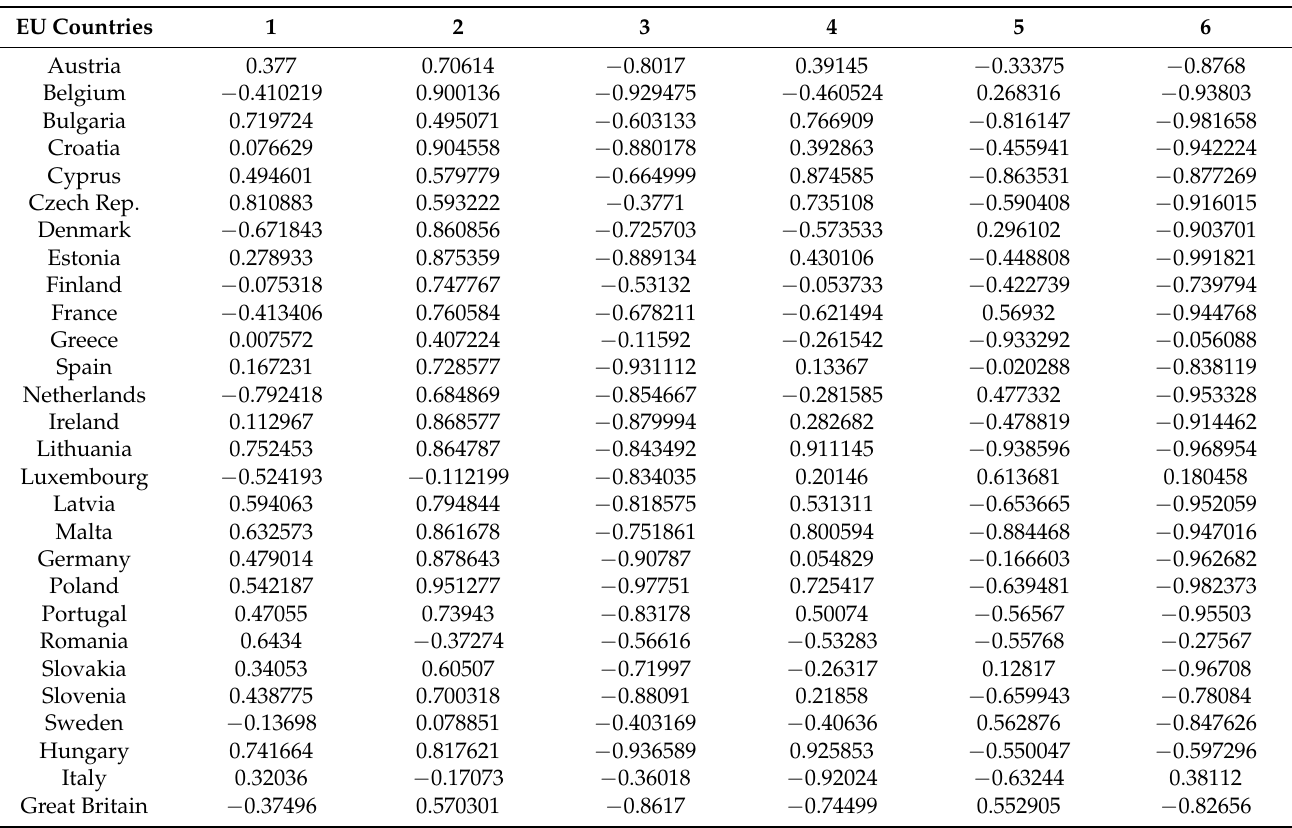
Table 2. Coefficients of correlation among air transport, greenhouse gas emissions, environmental tax impacts from transport and